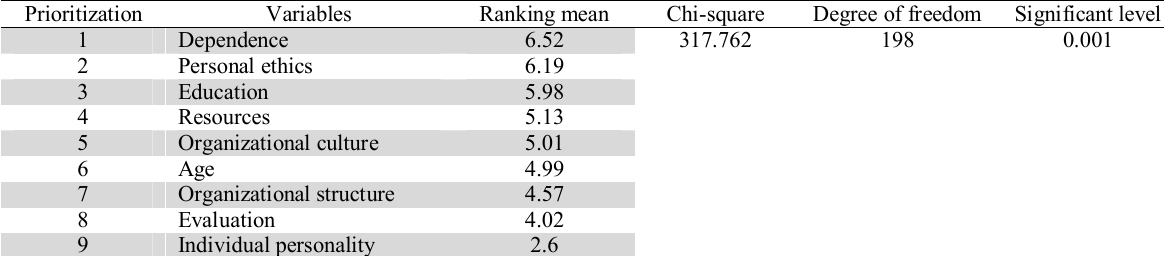
Results of Freedman